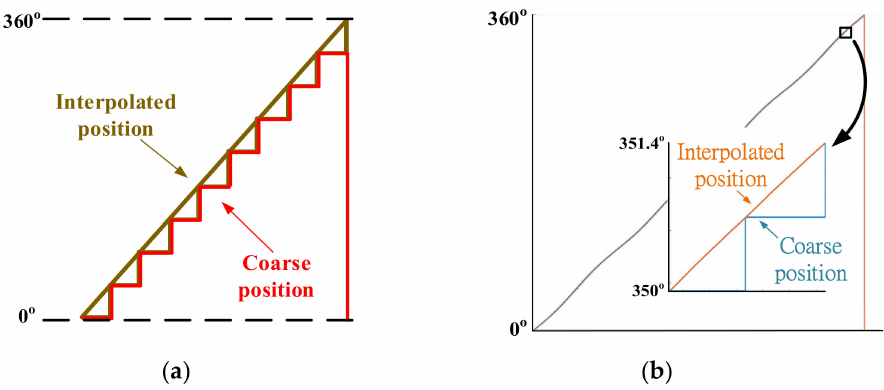
Figure 5. Position interpolation between encoder pulse counts: ( a ) conceptual interpolation process and ( b ) experimental result from the test motor (9-bit pulses + 16-bit ADC).